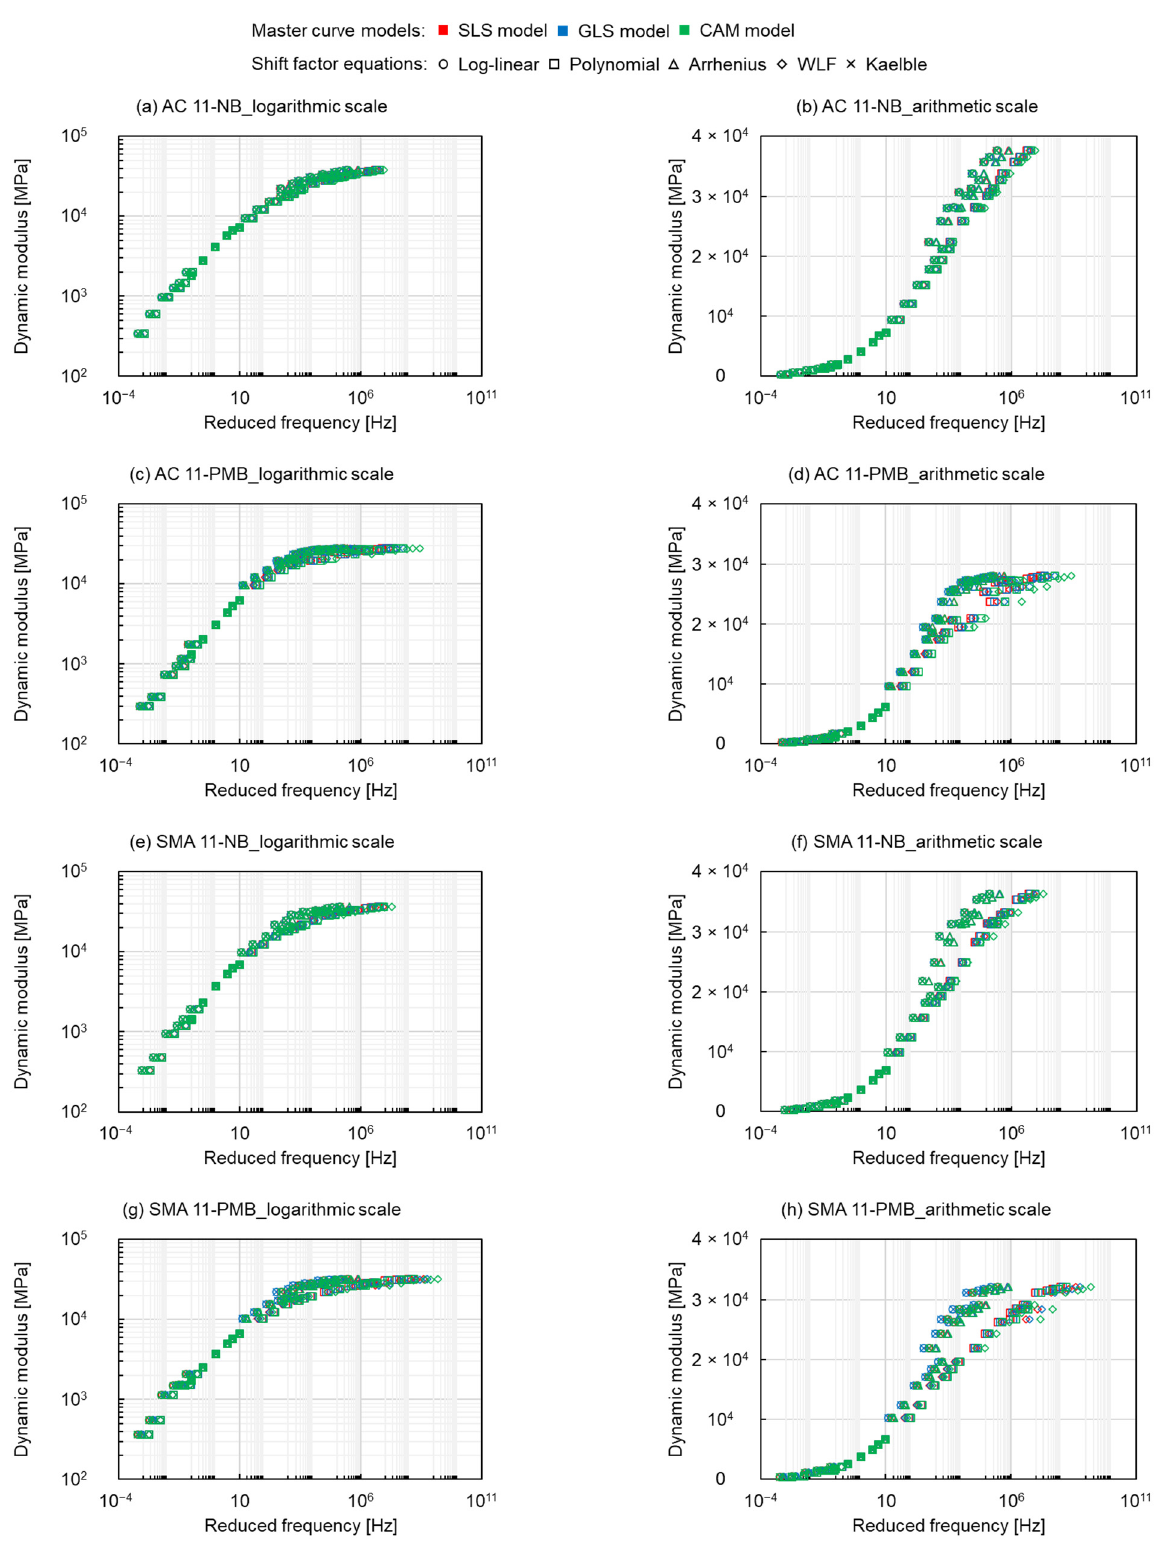
Figure 5. Dynamic modulus master curves of ( a ) and ( b ) AC 11-NB, ( c ) and ( d ) AC 11-PMB, ( e ) and ( f ) SMA 11-NB and ( g ) and ( h ) SMA 11-PMB.